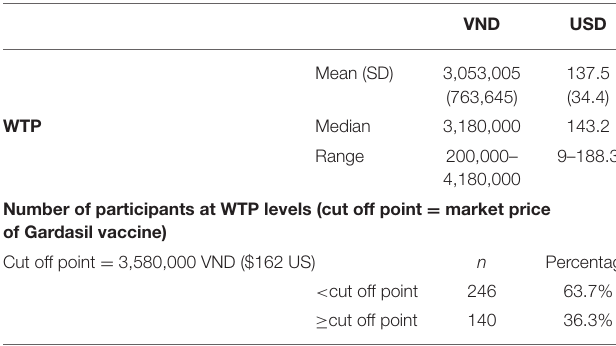
TABLE 4 | Willingness to pay for HPV vaccination for sons among the parents ( n = 386).